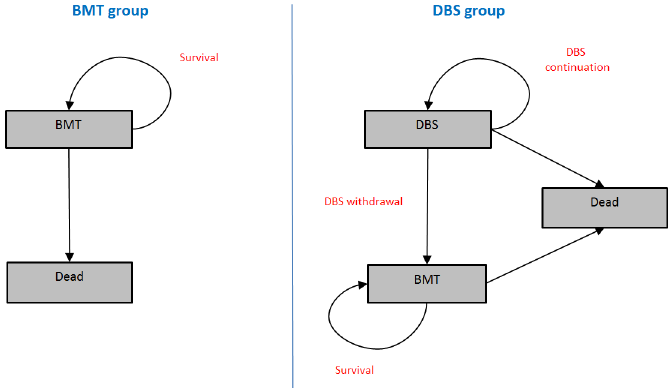
Fig 1. Model diagram BMT = best medical therapy; DBS = Deep brain